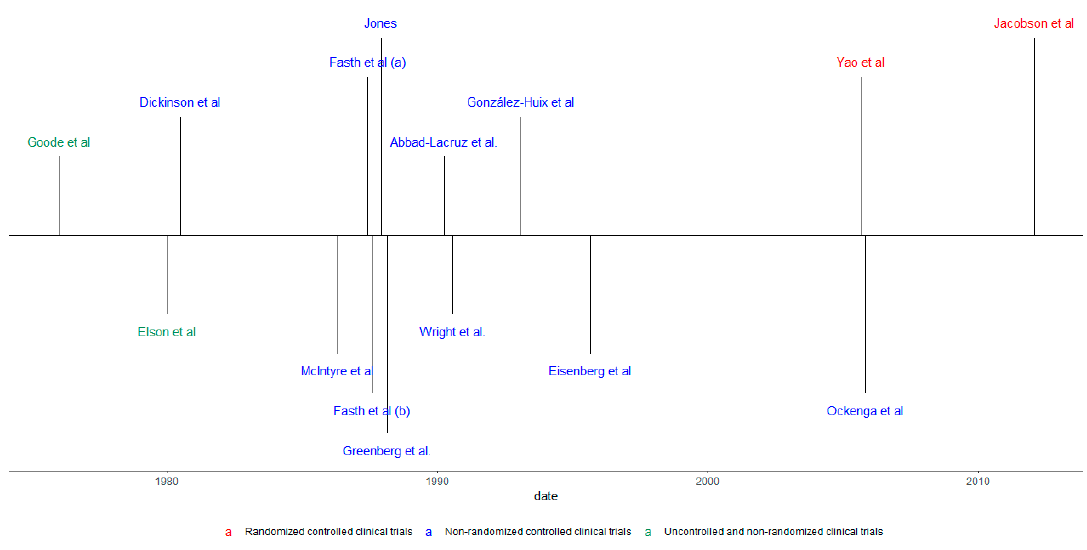
Figure 2. Chronological review according to the type of study and population.